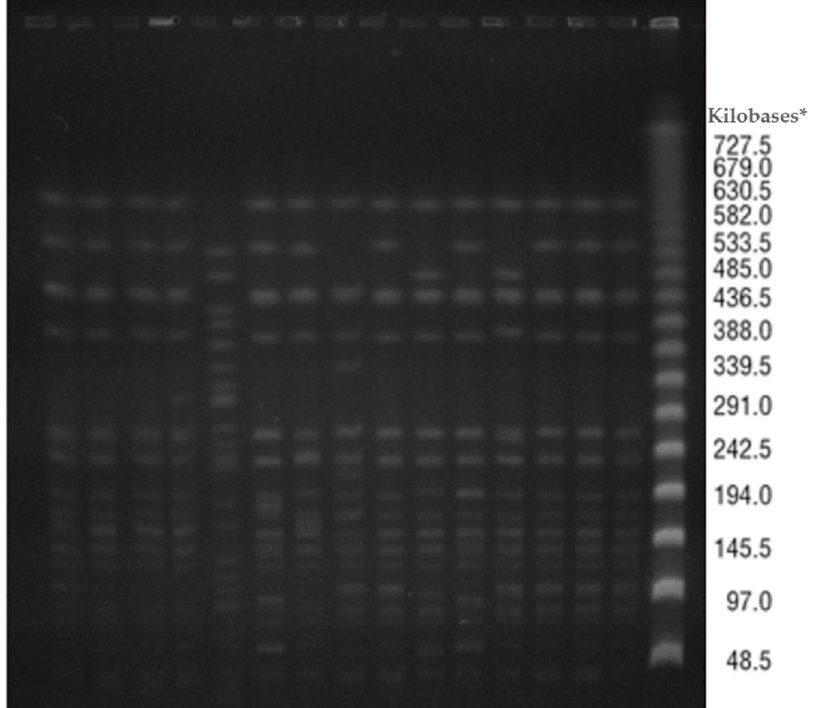
Figure 3. Distribution of PFGE patterns of selected random isolates circulating in the regional healthcare network. (Marches region, Italy, 2014). * As reference standard a Lambda Ladder PFG marker was used (NewEngland BioLabs, Ipswich, MA, USA).